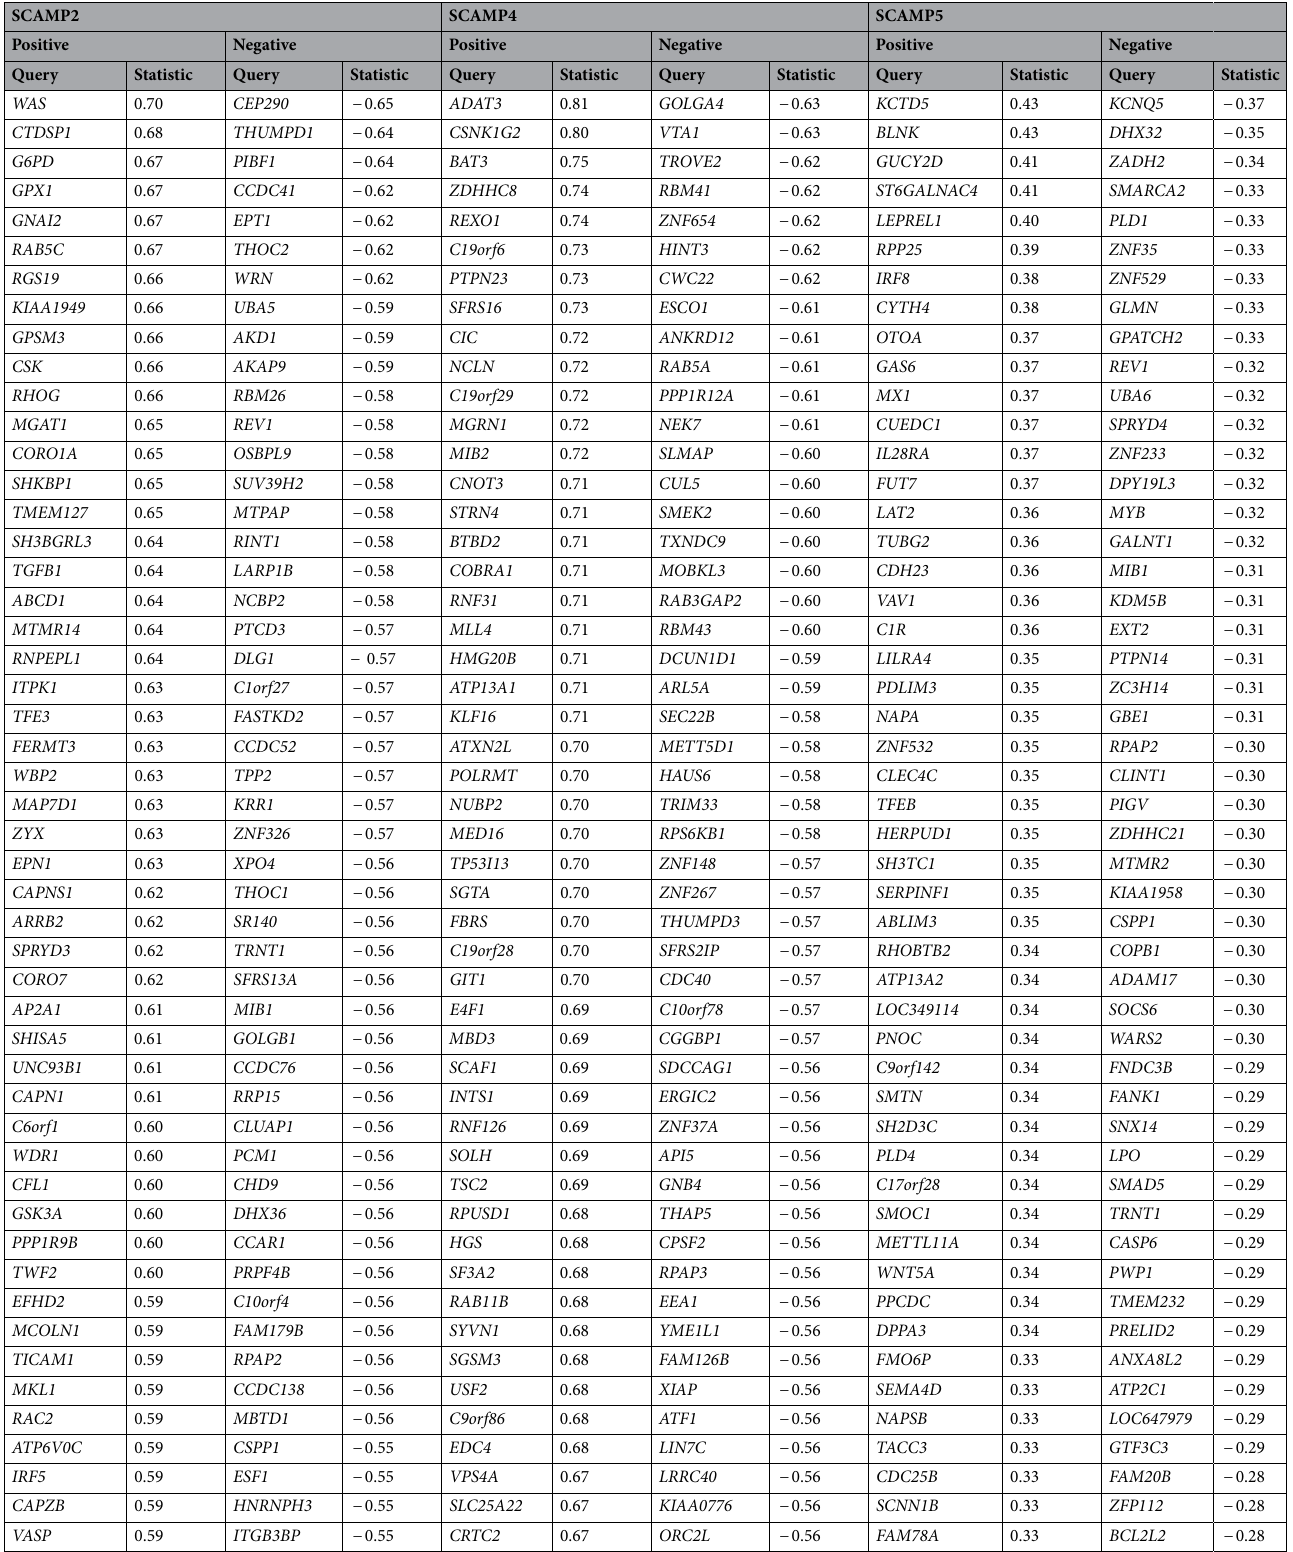
Table 2. The top 50 co-expressed genes of SCAMPs in AML